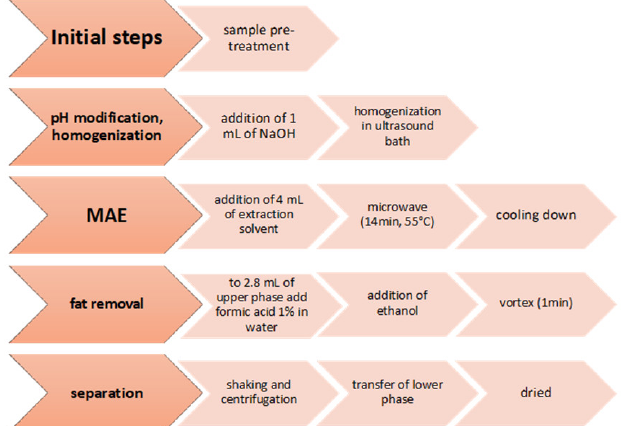
Figure 2. The sample preparation procedure of human bone marrow aspirate.